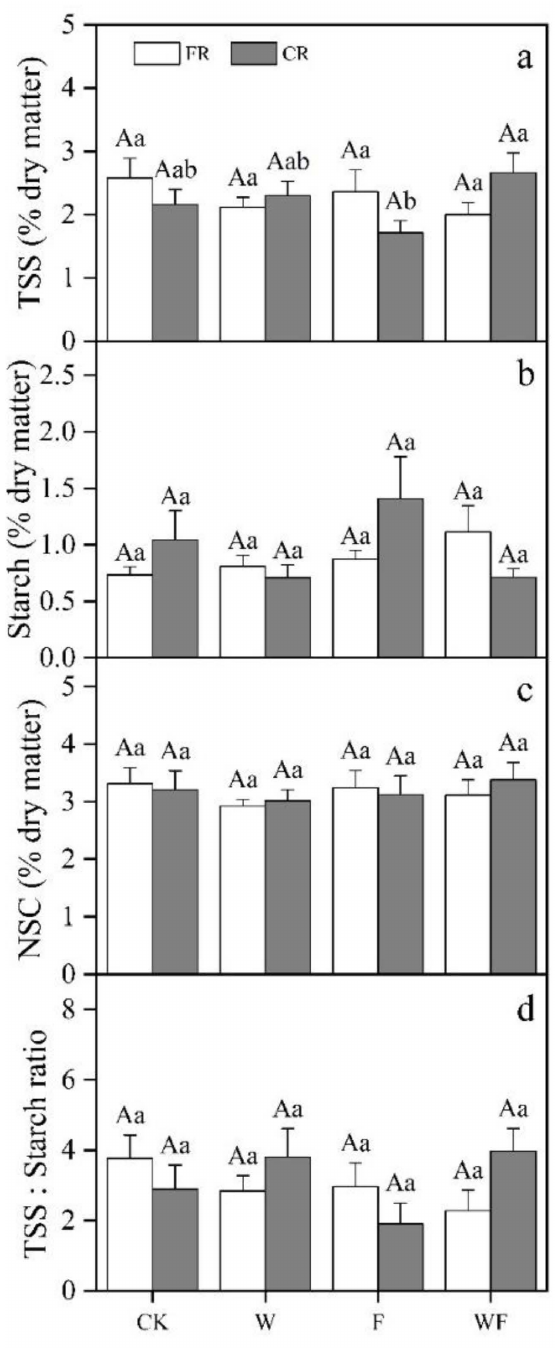
Figure 4. Changes in TSS, starch, NSC concentration and ratio of TSS to starch in the roots of E. urophylla × E. grandis under different treatments. The average value and standard error of each time are shown ( n = 5). The letters ( a – d ) indicate the concentrations of TSS, starch, NSC and the ratio of TSS to starch, respectively. The letters over the bars represent the results of Duncan’s multiple comparison analysis. Different capital letters indicate significant differences between fine root (FR) and coarse root (CR) under the same treatment ( p < 0.05). Different lower-case letters indicate significant differences between different treatments for the same tissues ( p <